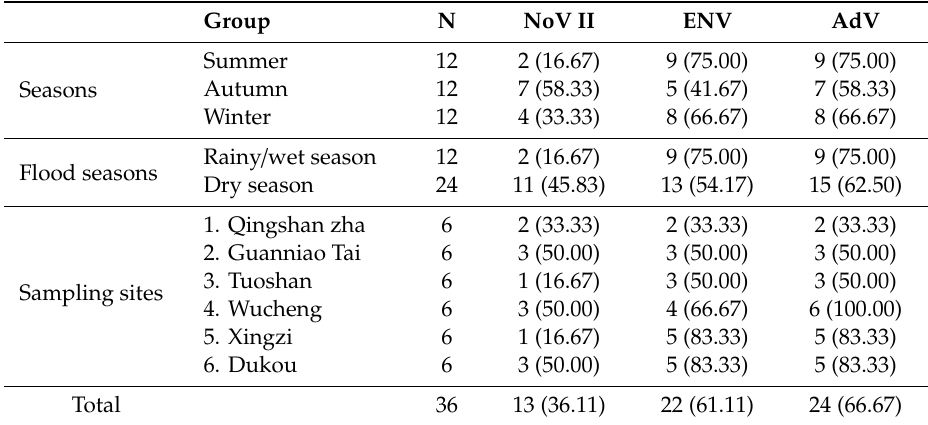
Table 6. Detection of enteric viruses among di ff erent seasons and sampling sites through Hawaii’s method qualitative